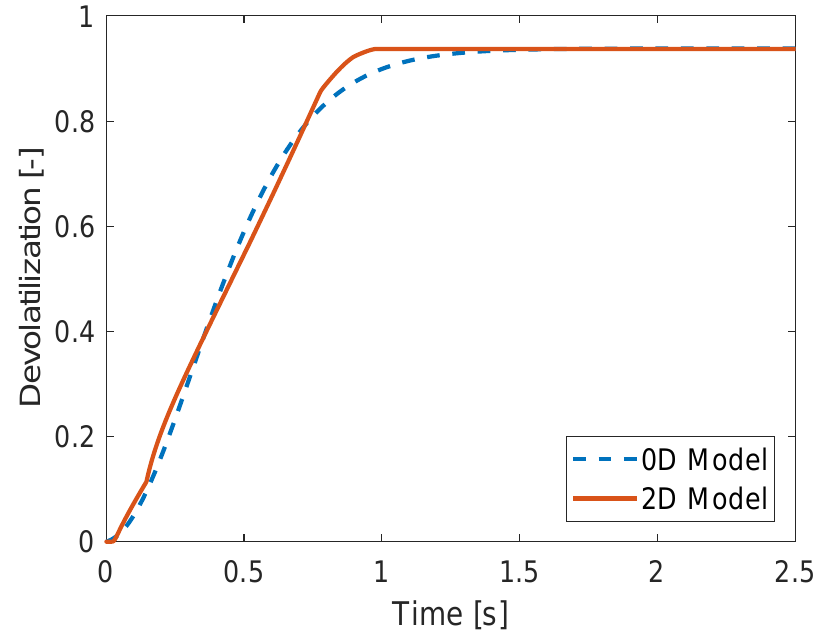
Figure 2. Example of fitting the 0D model to the semi-2D cylindrical model, here for a dry particle of d p = 1510 µ m, AR = 2, and ρ = 700 kg/m 3 with T g = 1600